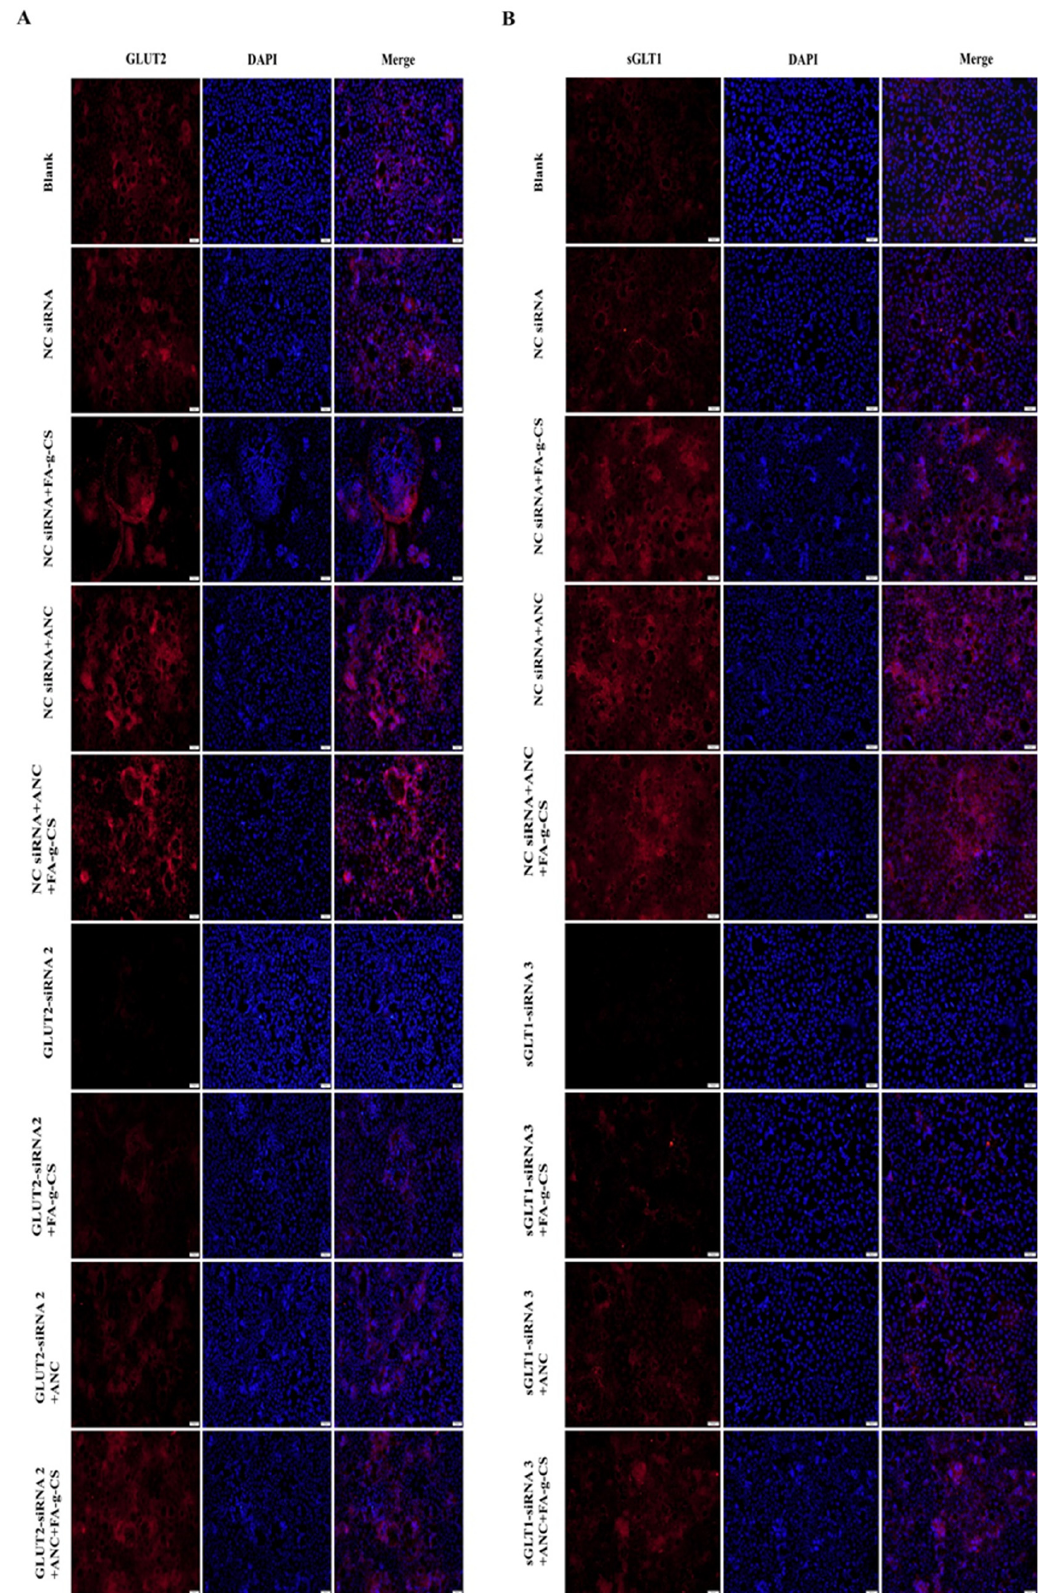
Figure 4. Effects of ANC and FA-g-CS on the protein levels of GLUT2 ( A ) or sGLT1 ( B ). Caco-2 cells were treated with the indicated ANC (2.3 × 10 − 4 mg/mL), FA-g-CS (9 × 10 − 5 mg/mL), or their combination for 48 h.